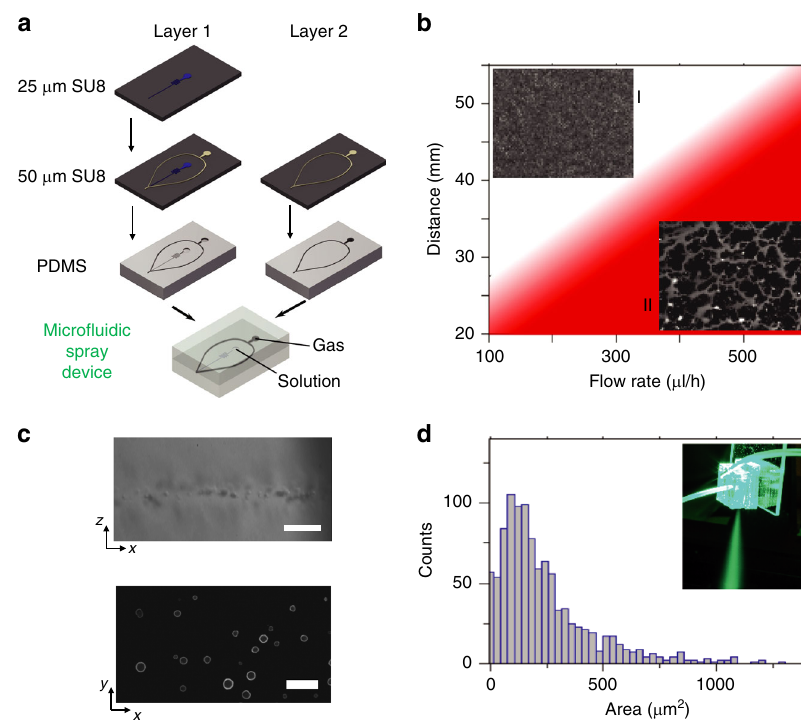
Fig. 2 Single-step deposition by a micro fl uidic spray device. a Preparation of the micro fl uidic spray device. b Diagram representing the conditions, fl ow rate and distance from nozzle to substrate, resulting in well-resolved individual droplets (I) and streams of fl uid due to coalescence (II), the insets in the diagram represent images of several layers of droplets for each condition. c Snapshots of real time videos showing deposition and drying of highly concentrated fl uorescein droplets at the saturation point and in condition of absence of coalescence (scale bar: top, 50 μ m; bottom 100 μ m). d Histogram of the distribution of the size droplets imprints ( n = 1032), the graph represents the distribution of the measured surface area of individual droplets, using a nitrogen pressure of 3.5 bar. The inset shows a photograph of the device in